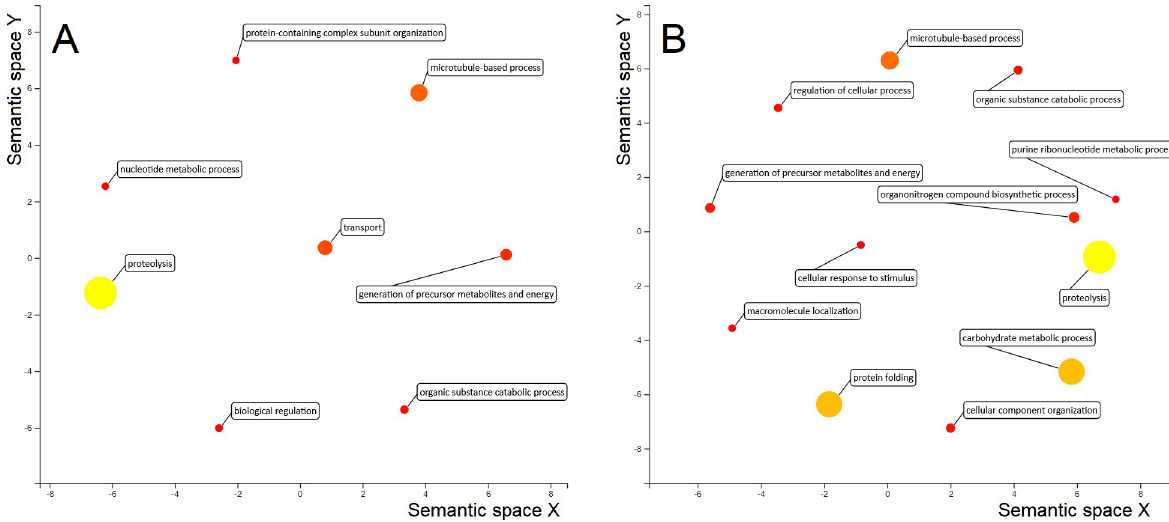
Fig 6. ReViGO plot showing the main GO terms within the Biological Process (BP) category in FhNEJ. The BP GO terms corresponding to up- and down-regulated proteins in the detergent-soluble extract enriched with tegument (A) and soma (B) extracts of FhNEJ after incubation with MPSIEC are shown. The size and colour of each circle represents the Nodescore of each GO term, and the spacing between circles refers to the similarity between the represented terms.